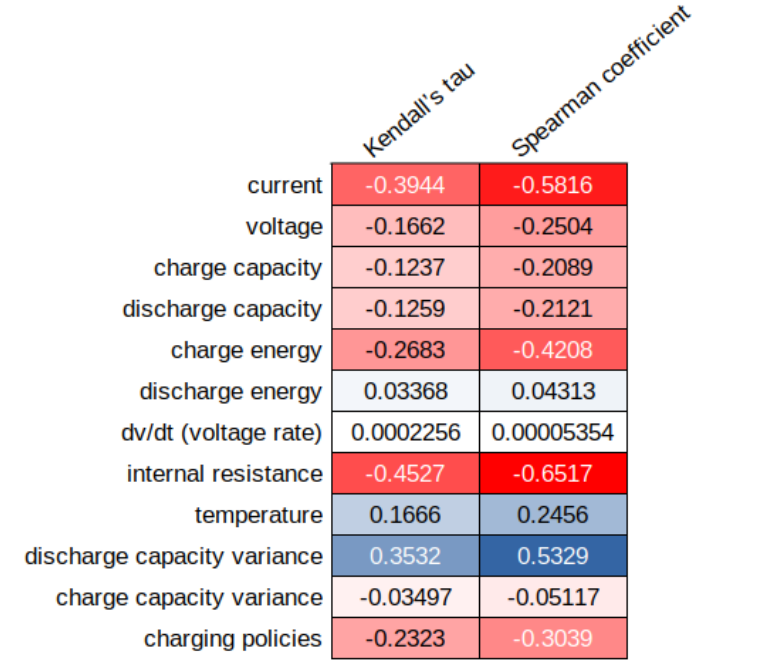
Figure 7. Results from variable importance analysis. Kendall’s tau and Spearman coefficient for all input features were evaluated. Values close to 0 (white color) mean no importance, while values close to either 1 (blue color) or − 1 (red color) mean strong